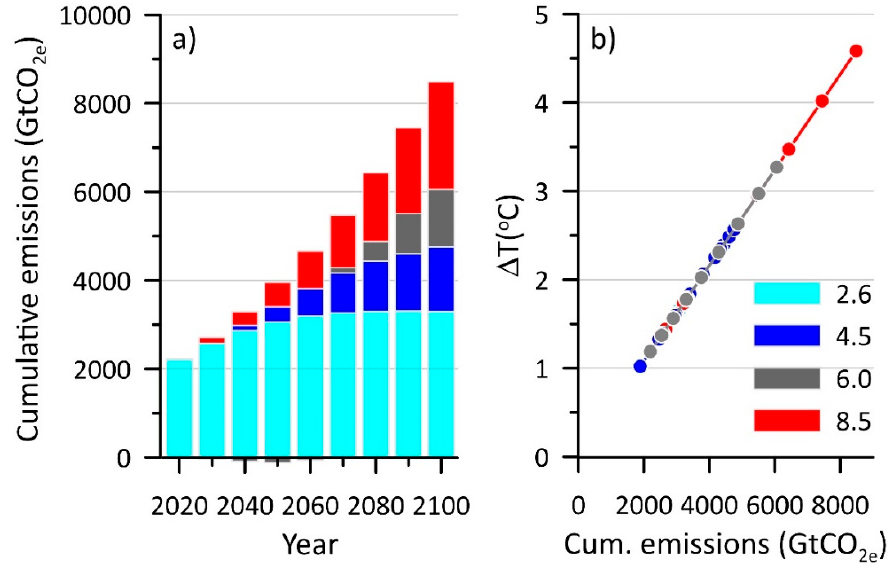
Figure 5. Representative Concentration Pathways (RCP) from the Intergovernmental Panel on Climate Change Emissions Scenarios [34] . ( a ) Cumulative CO 2 emissions in GtCO 2e relative to the pre-industrial. The RCP scenarios X.X refer to a forcing equivalent to 2.6 Wm − 2 , 2.6 to 4.5 Wm − 2 (total bar height), 4.5 to 6.0 Wm- 2 (total bar height), and 6.0 to 8.5 Wm − 2 (total bar height) by the end of the century. ( b ) Temperature increases relative to pre-industrial levels calculated using TCRE of Δ T = 0.54 °C per 1000 GtCO 2 .